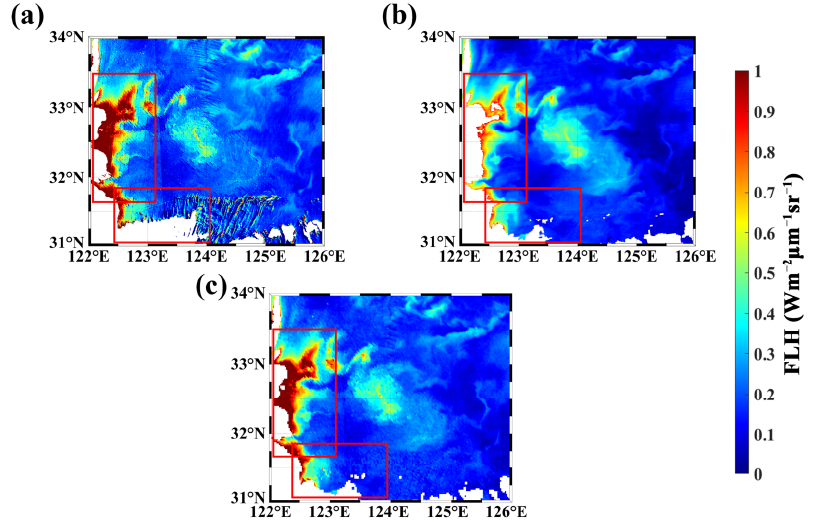
Figure 13. Satellite FLH product on 27 April 2012: ( a ) GOCI satellite FLH product (calculated using the new algorithm in this study), ( b ) MODIS satellite FLH product (calculated using the new algorithm in this study), and ( c ) fusion FLH product results. The red frames are the regions where the fusion results are more significant.